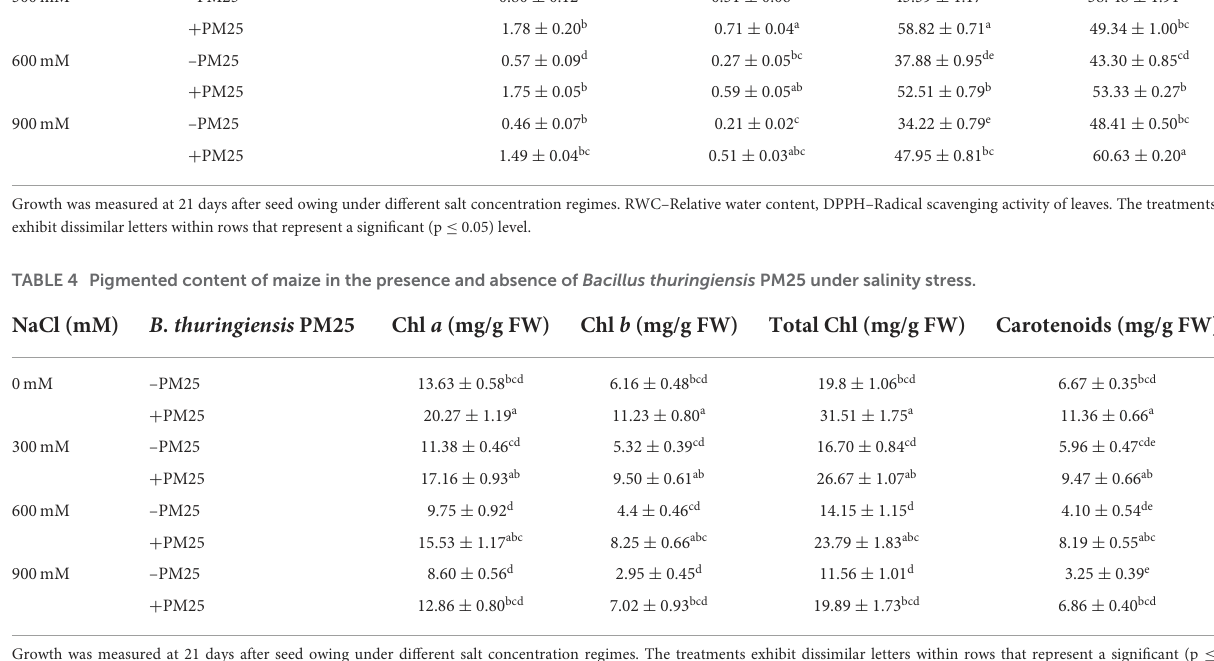
while compared to controlled plants (Figure 5). As 900-mM- NaCl stress was applied, the highest decrease in TSS and a considerable increase in total protein content were recorded compared to the control plants. Furthermore, PM25-treated plants had increased levels of total soluble sugars and proteins compared to uninoculated plants (Figure 5). The application of